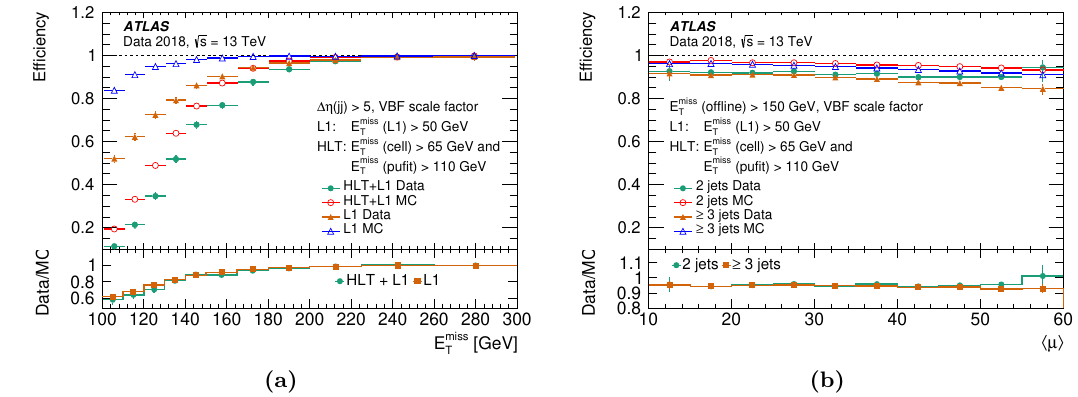
Figure 12. E(cid:14)ciencies from data and from simulation for L1 ( L1XE50 ) and the combined L1+HLT chain ( HLT xe110 putfit xe65 L1XE50 ) triggers are shown for a VBF selection which requires at least two jets that are well separated in rapidity. The uncertainties are statistical only. The lower panels show the ratios between e(cid:14)ciencies in data and simulation. (a) E(cid:14)ciencies as a